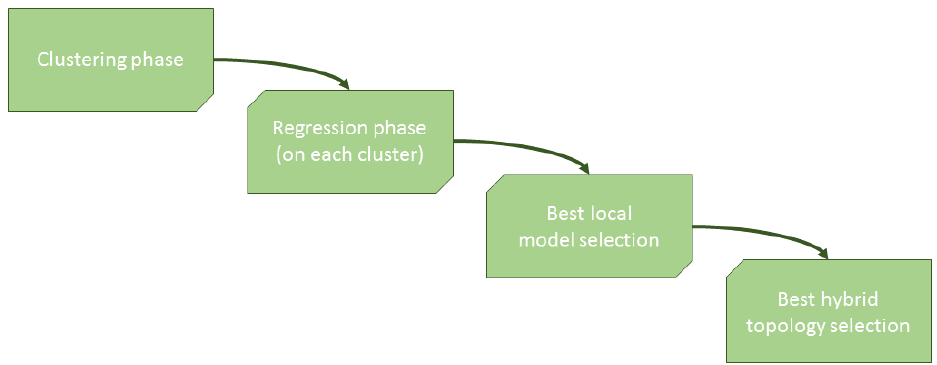
Figure 6. Flowchart of the hybrid model creation phases.